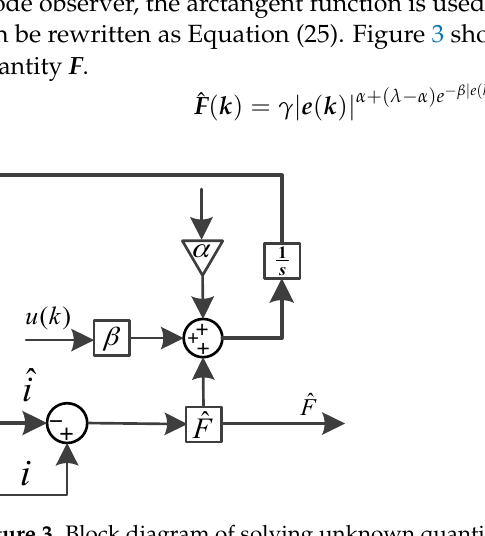
Figure 3. Block diagram of solving unknown quantity ˆ F .